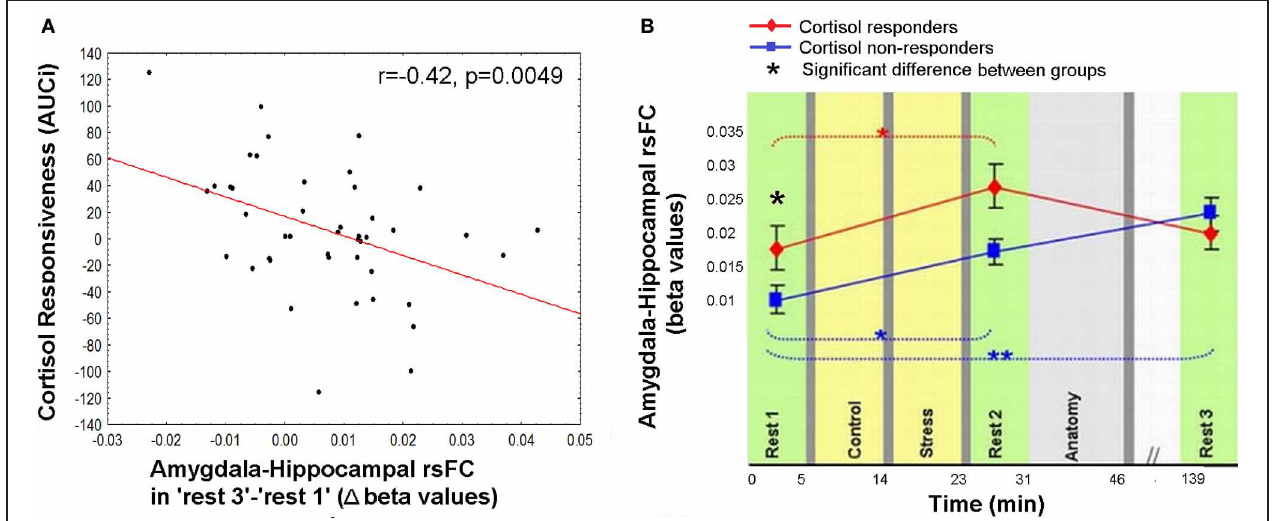
calculated separately for cortisol responders (red) and non-responders (blue), and presented in reference to the timeline of the experiment. Between-groups differences were found in “rest 1” and “rest 2,” and within the non-responders group between “rest 1” and “rest 3.” The error bars indicate standard error. ∗ p < 0 . 05, ∗∗ p < 0 .